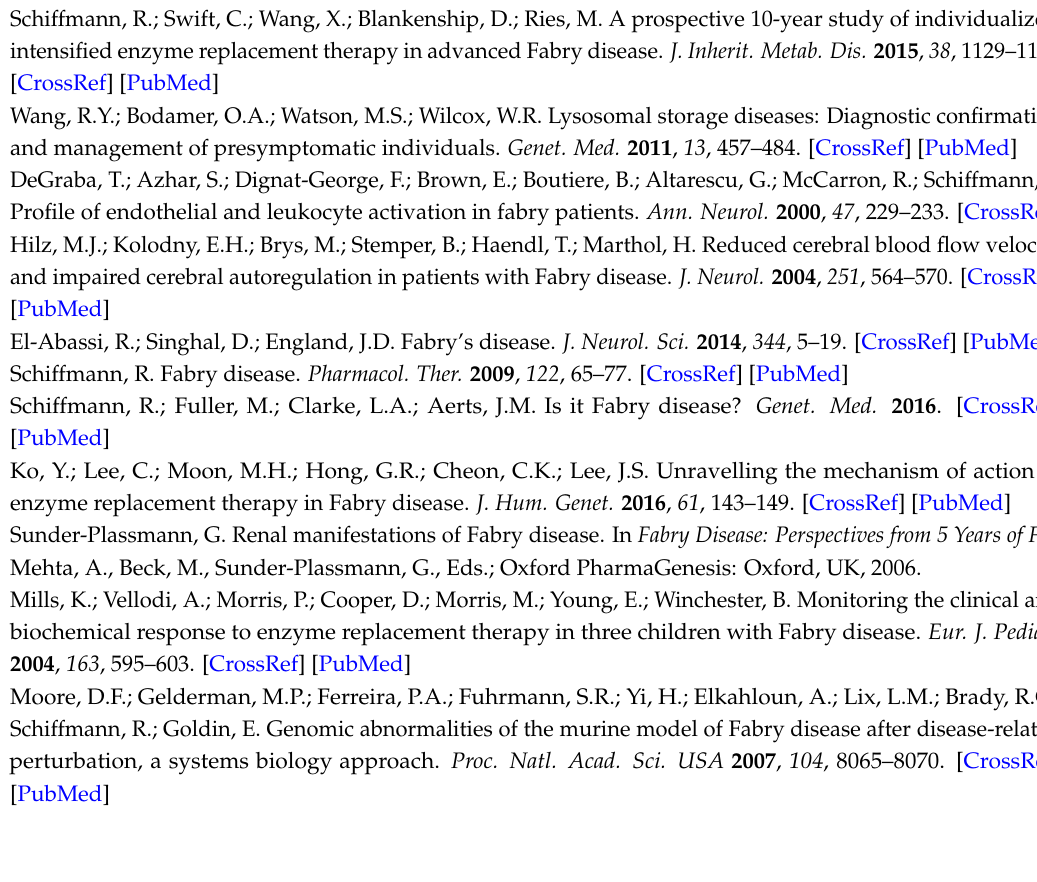
Figure S1: Reactome terms representing molecular regulation for Fabry-naïve patients, Figure S2: KEGG terms representing molecular regulation for Fabry-naïve patients, Figure S3: WikiPathways terms representing molecular regulation for Fabry-naïve patients, Figure S4: Reactome terms representing molecular regulation for ERT patients, Figure S5 WikiPathways terms representing molecular regulation for ERT patients, Figure S6: Naïve group molecules plus the most relevant molecules from DisGeNET = 100 nodes and 1517 edges, Table S1: Most frequent genes/proteins found across the naïve patients datasets and their respective functional tag and regulation, Table S2: Most frequent genes/proteins found across the ERT patients datasets and their respective functional tag and regulation, Table S3: GO and pathway terms clustering from ClueGO analysis of data of the FD group, Table S4: GO and pathway terms clustering from ClueGO analysis of data of the ERT group, Table S5: Top 10 gene associations for Fabry disease, Table S6: Top 10 diseases and phenotypes that share genes with Fabry disease, Table S7: Shared genes with Fabry disease amongst the kidney diseases